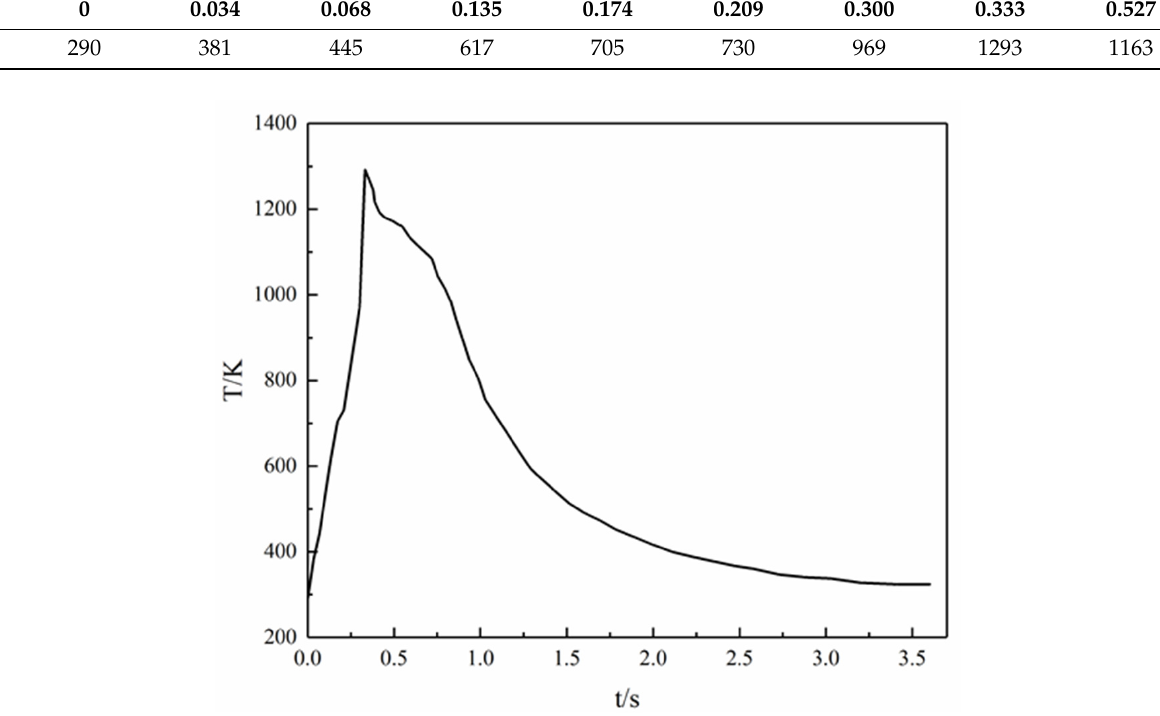
Figure 7. The curve of MgB 2 sample ignition temperature.